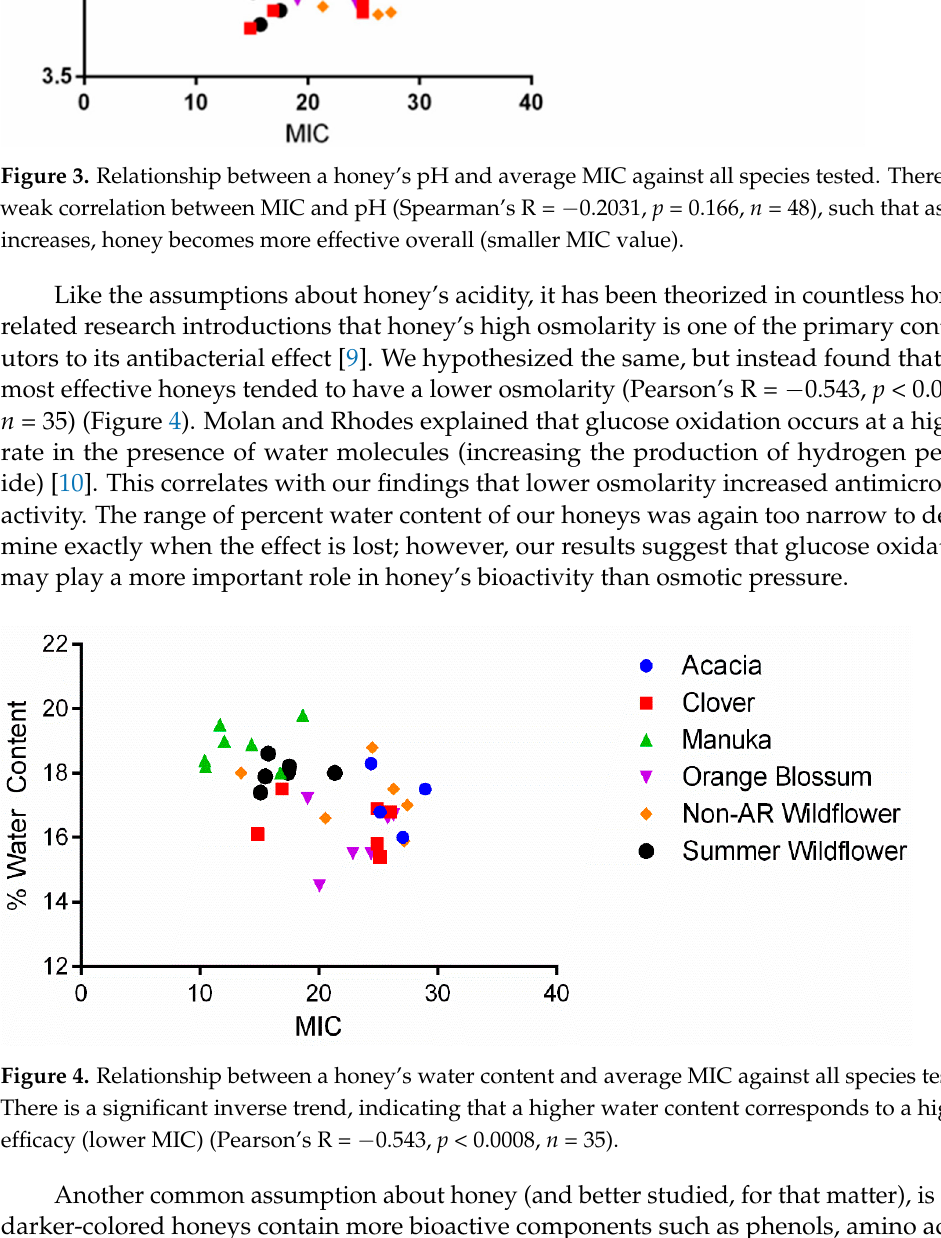
Figure 3. Relationship between a honey’s pH and average MIC against all species tested. There is a weak correlation between MIC and pH (Spearman’s R = − 0.2031, p = 0.166, n = 48), such that as pH increases, honey becomes more effective overall (smaller MIC value).